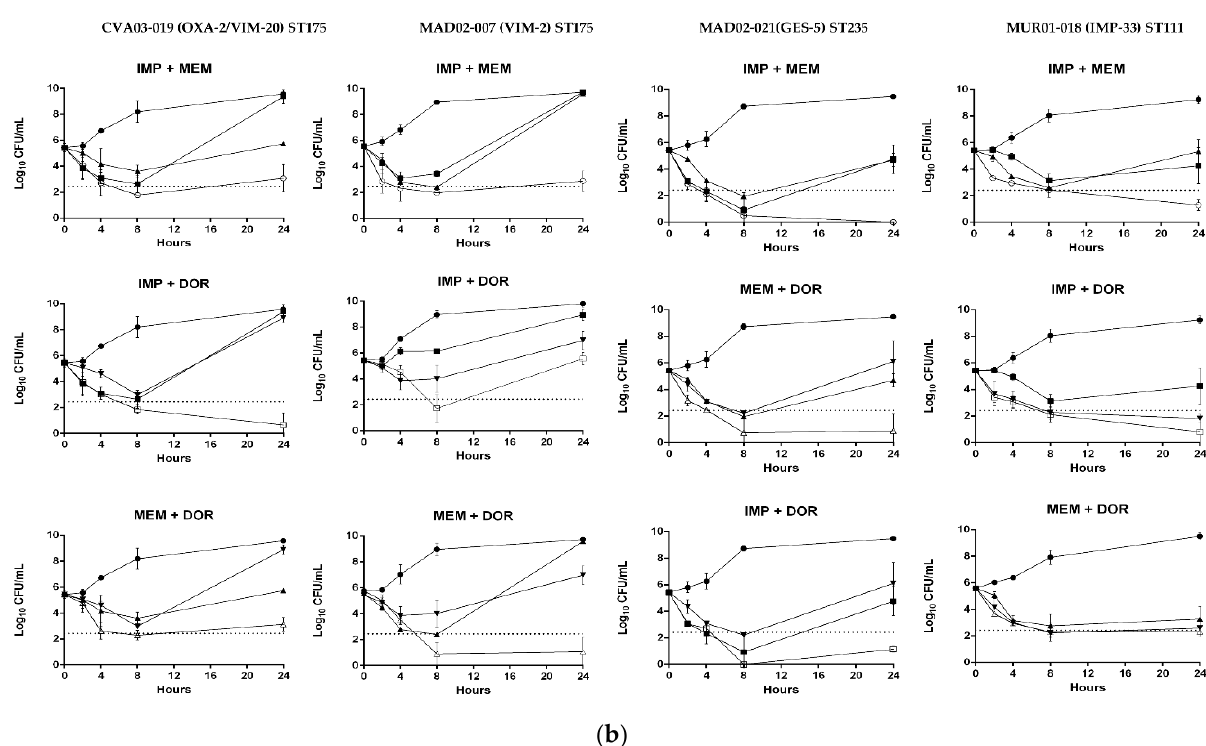
Figure 1. ( a ) Time-kill assays for imipenem, meropenem, and doripenem alone and in combination at MIC concentrations against eleven isolates of carbapenemase-producing P. aeruginosa isolates. Results are represented as differences (log 10 CFU/mL) relative to the initial time point (0 h). Green indicates a >3 log 10 CFU/mL decrease, yellow a <3 log 10 CFU/mL decrease. Bold represents synergistic activity with respect to the most active drug alone at that time point. IMP: imipenem; MEM: meropenem; DOR: doripenem. ( b ) Time-kill assays for imipenem, meropenem, and doripenem alone and in combination at MIC concentrations against the four carbapenemase-producing P. aeruginosa isolates selected for in vivo studies. Solid circle: growth control; Square: imipenem (IMP); Triangle: meropenem (MEM); Inverted triangle: doripenem (DOR); Empty circle: IMP + MEM; Empty square: IMP + DOR; Empty triangle: MEM + DOR; Dotted line: bactericidal activity.